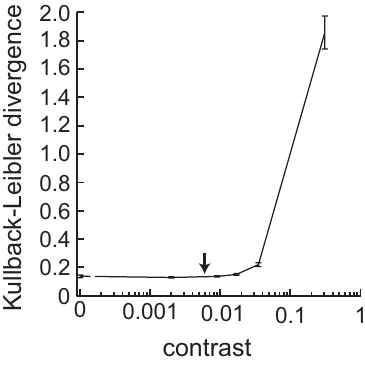
Figure 3. Kullback-Leibler divergence as a function of the contrast. Average Kullback-Leibler divergence 6 95% confidence interval at the different contrast (N=12). For each recorded cell the Kullback-Leibler divergence was estimated at each instance of time and was subsequently averaged across time giving a single divergence value for each cell at each contrast level (see methods). The plotted values are averages of these divergences across the 12 cells.